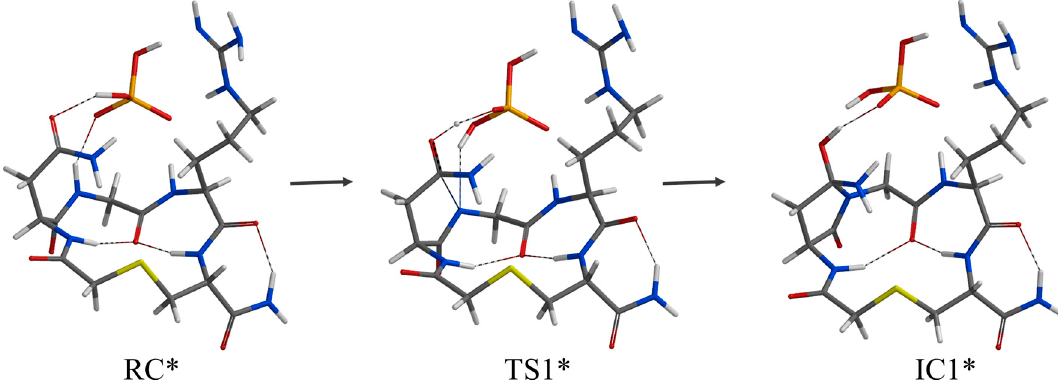
Figure 2. The first step (cyclization to the tetrahedral intermediate) of the succinimide formation from c[CH 2 CO–NGRC]–NH 2 (CP15) found in the previous study [67]. RC: reactant complex; TS: transition state; IC: intermediate complex. These geometries are labeled by an asterisk (*) to indicate that they can be reproduced from the reported Cartesian coordinates [67] (see text). Grey: carbon; white: hydrogen; blue: nitrogen; red: oxygen; orange: phosphorus; yellow: sulfur.